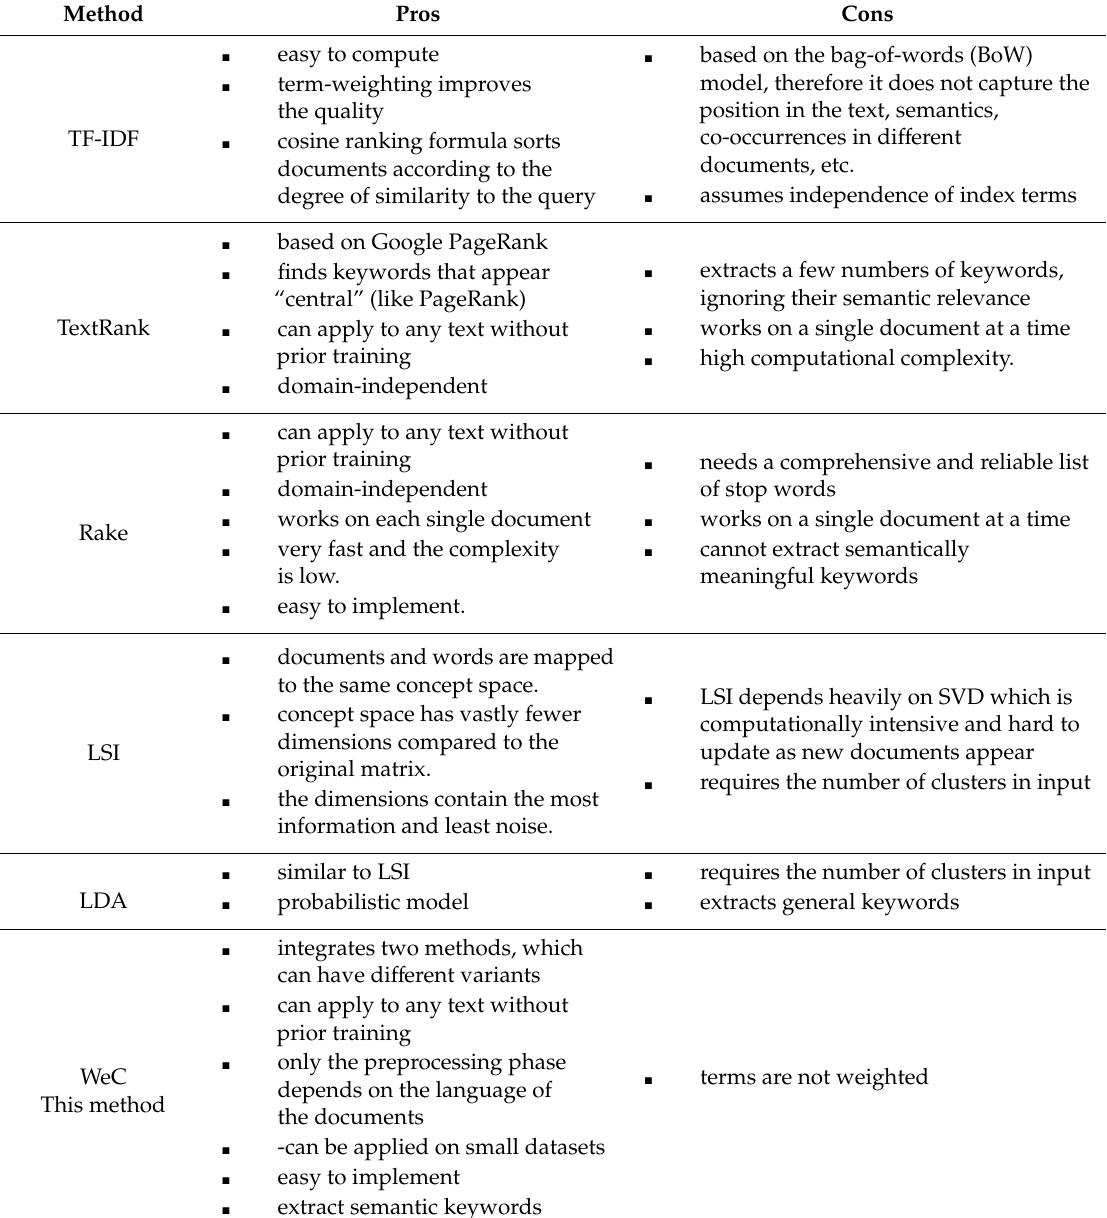
Table 1. Comparison of di ff erent unsupervised keyphrase extraction